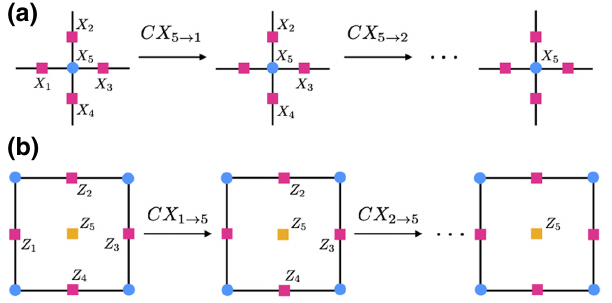
FIG. 2. The disentangling circuit. (a) The action of the dis- (cid:5) entangling circuit U v = CX v → (cid:2) on the qubits surrounding l ∈ v a vertex v . (b) The action of the disentangling circuit U p = (cid:5) CX v → p on the qubits surrounding a plaquette p . After appli- (cid:5) (cid:5) l ∈ p cation of the total circuit U = U p v U v , we are left with p matter qubits that are no longer dynamical. Thus, the “gauge” qubits are the only relevant degrees of freedom in the